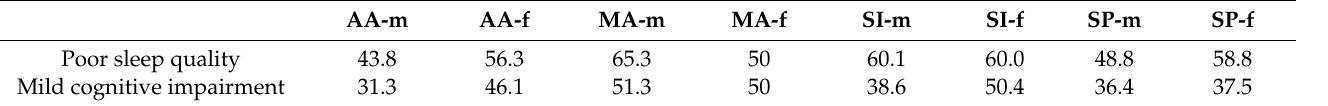
Table 2. Percentage of the presence of poor sleep quality and mild cognitive impairment in enrolled